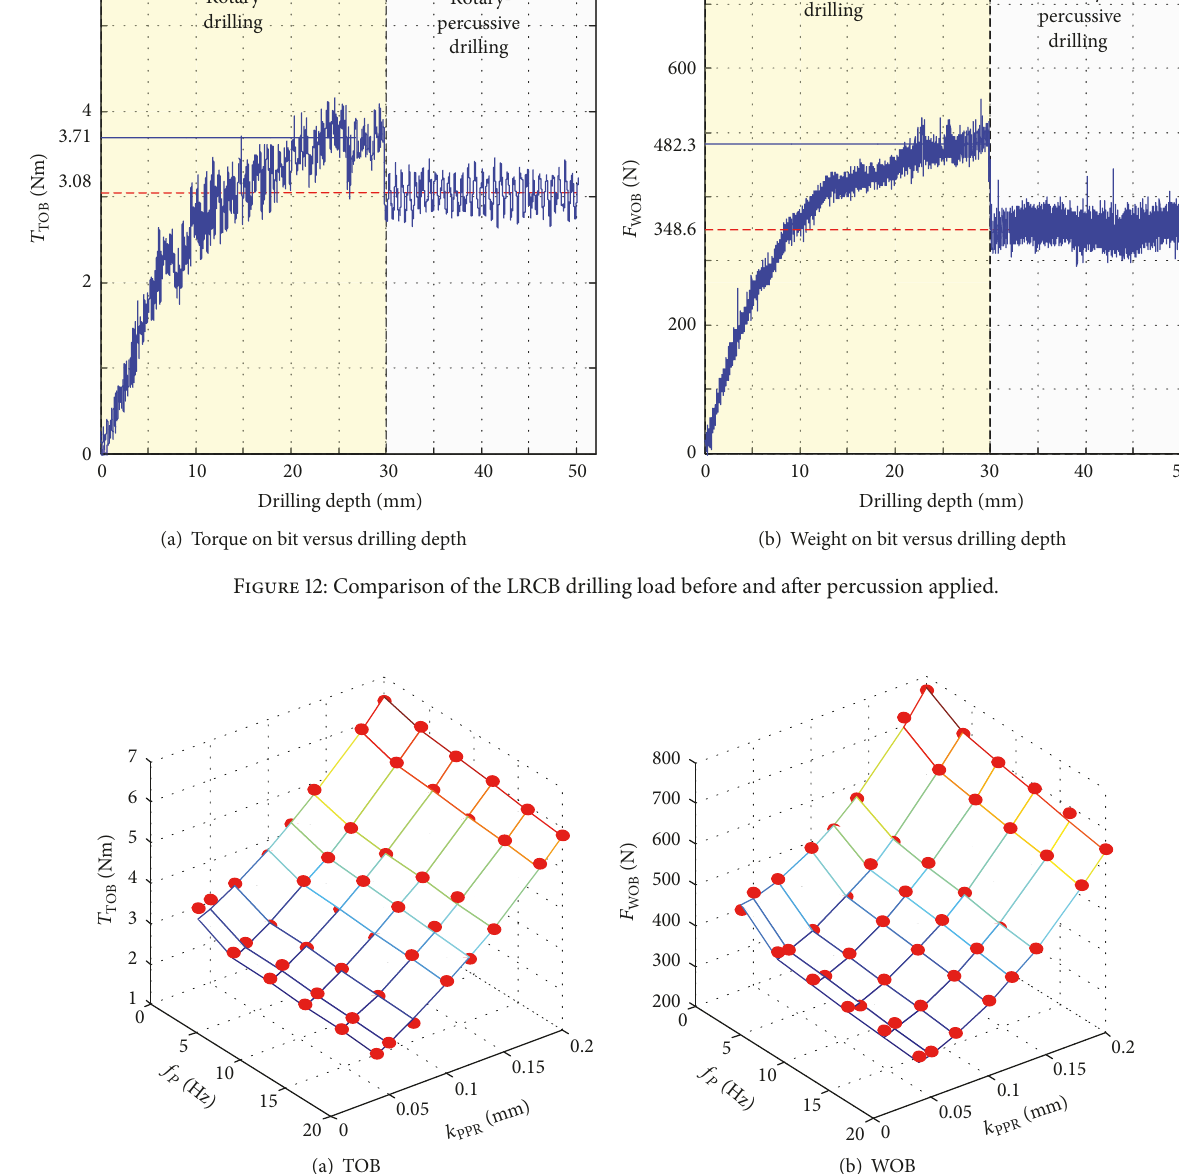
the magnescale sensor in a drilling cycle, a best-fit functional relationship between the fluctuation in the cut depth and